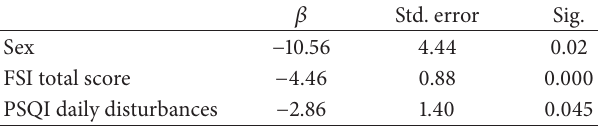
Table 3: Beta values and significance levels of predictor variables. 𝛽 Std. error Sig. Sex − 10.56 4.44 0.02 0.88